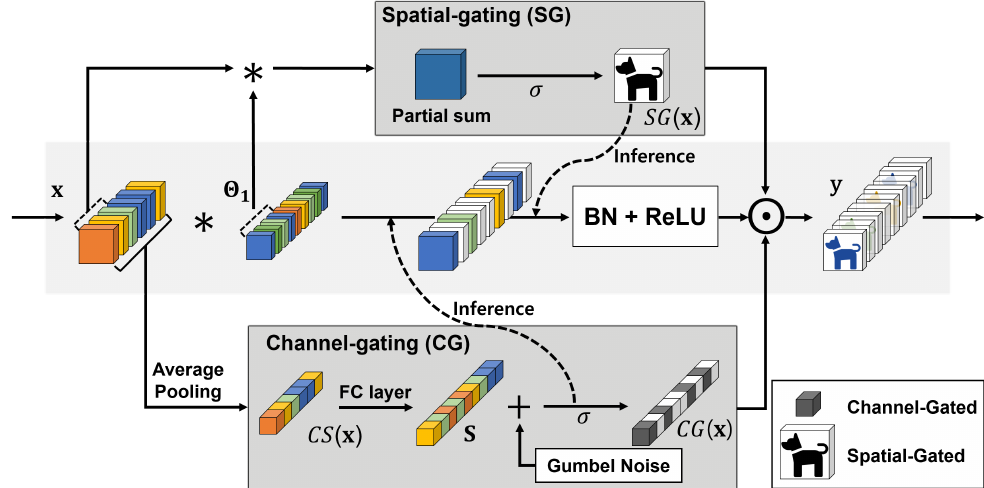
Figure 1. CSGN in the convolutional layer: CG generates a channel selection mask using Gumbel- SoftMax trick, and SG produces a spatial-wise mask with a partitioned